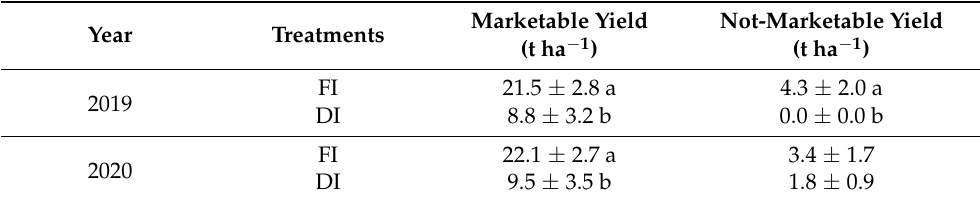
Table 4. Values ( ± SD) of panicle marketable and not marketable yield in full and deficit irrigated treatments. Data with different letters indicates significant difference at ( p ≤ 0.05).